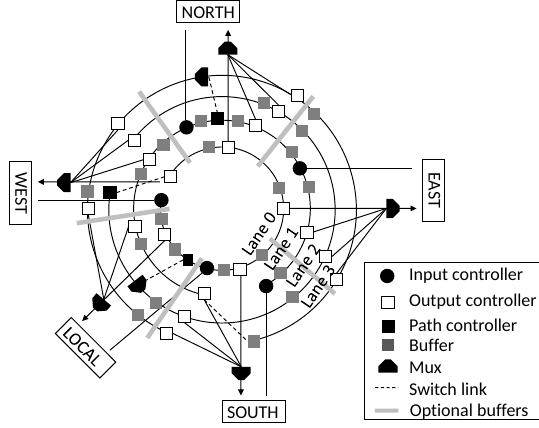
Figure 7. A 4-lane R-NoC